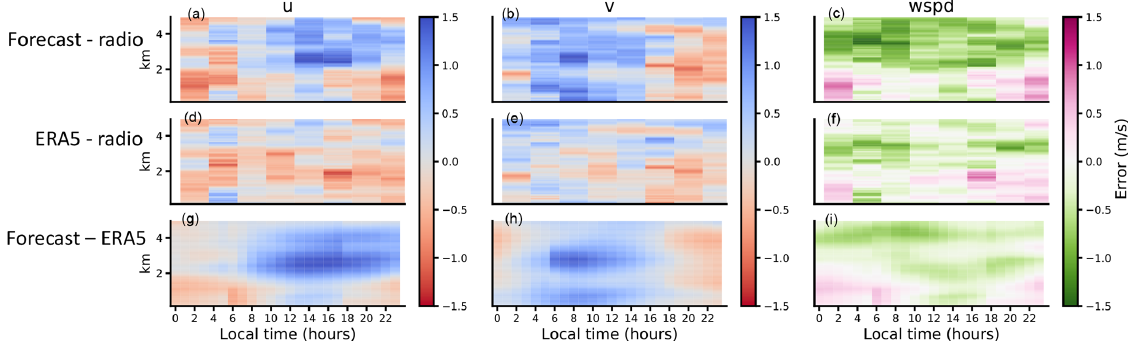
Figure 11. Diurnal cycle of the forecast bias with respect to radiosondes (a–c) , the ERA5 bias with respect to radiosondes (d–f) , and the forecast bias with respect to ERA5 (g–i) . From left to right, columns refer to the biases in zonal wind, meridional wind, and wind speed. Blue regions are related to a positive bias (e.g., negative zonal wind that is too weak), and red regions are related to a negative bias (e.g., wind speed that is too